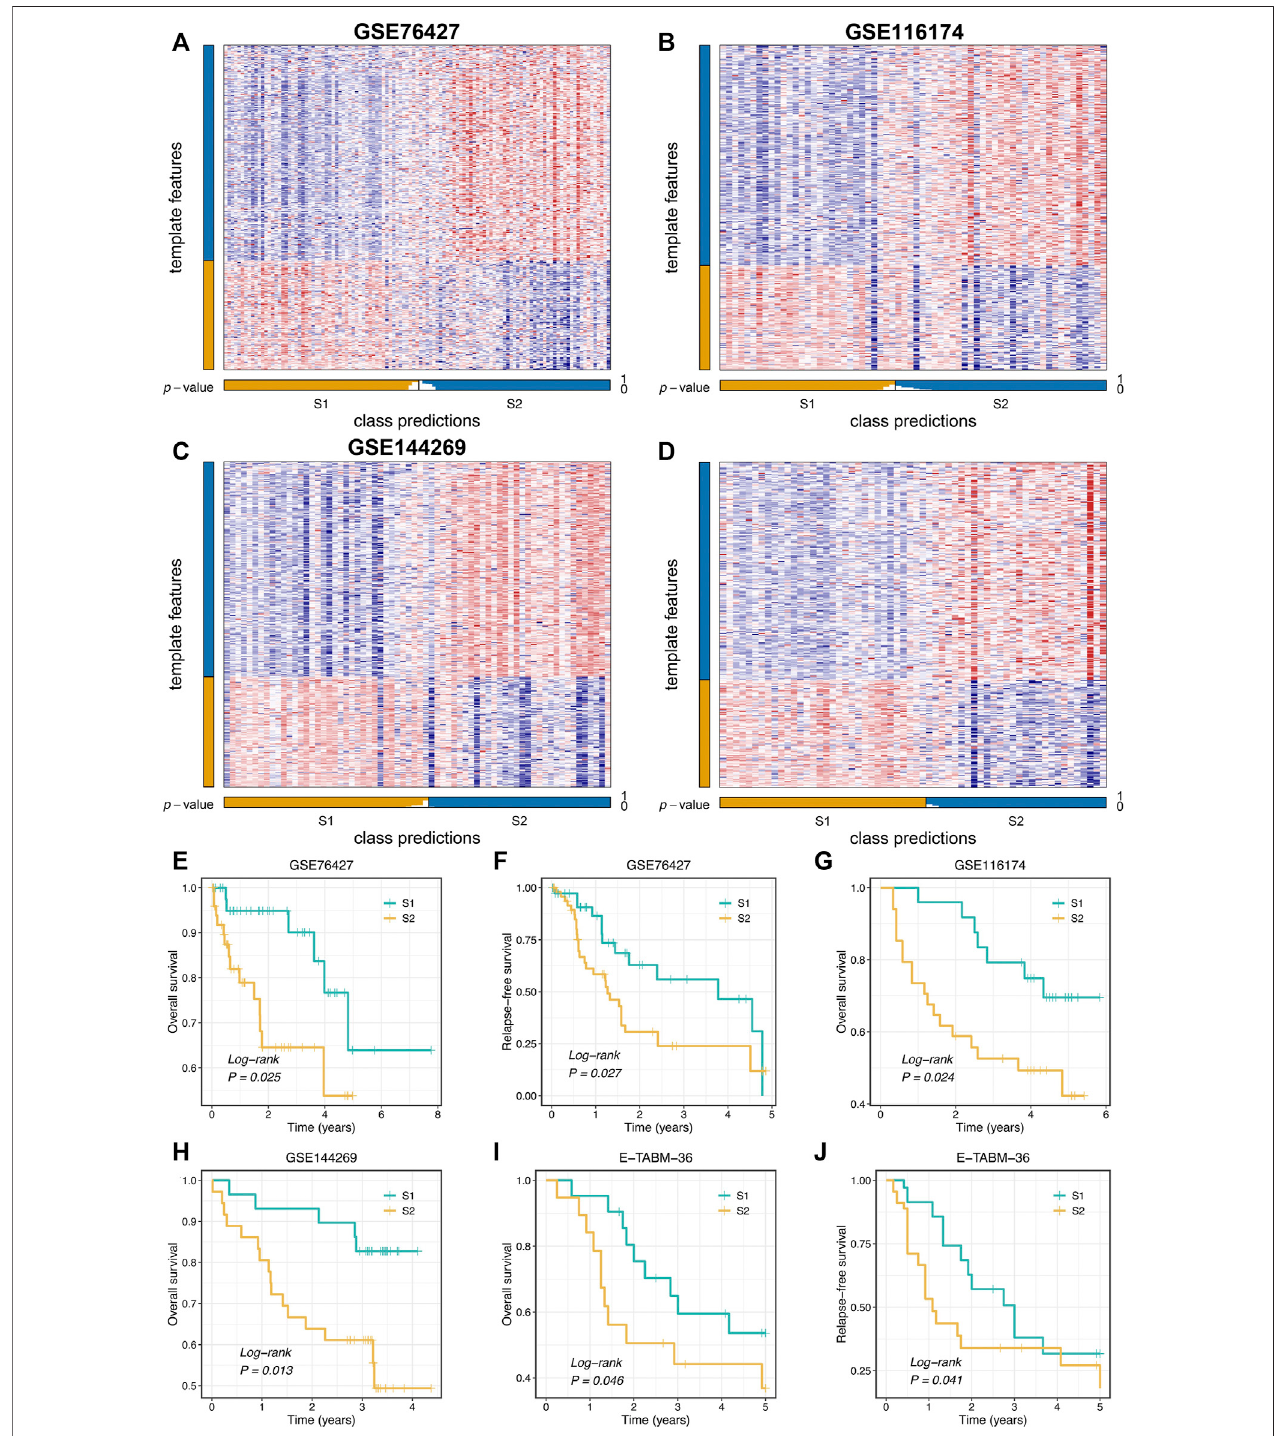
FIGURE4| Validationofproliferation-relatedsubtypes. (A – D) HeatmapoftheexpressionlevelofthetemplatefeaturebetweentwosubtypesintheGSE76427 (A) , GSE116174 (B) , GSE144269 (C) , and E-TABM-36 (D) datasets, respectively. (E,F) Kaplan-Meier curves of OS (E) and RFS (F) between the two subtypes in GSE76427. (G,H) Kaplan-Meier curves of OS between the two subtypes in GSE116174 (G) and GSE144269 (H) . (I,J) Kaplan-Meier curves of OS (I) and RFS (J) between the two subtypes in E-TABM-36.